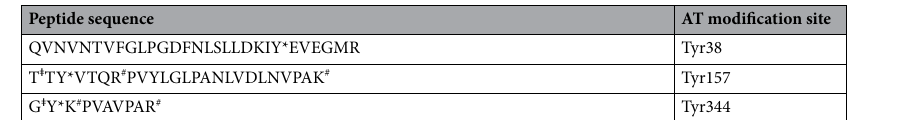
Table 1. Identified peptides of Pdc1 containing trace of PTN in the proteomic analysis. Y* = Tyr residues detected as AT, # = SILAC labeling of Lys (K) and Arg (R), ǂ = N-terminal acetylation.